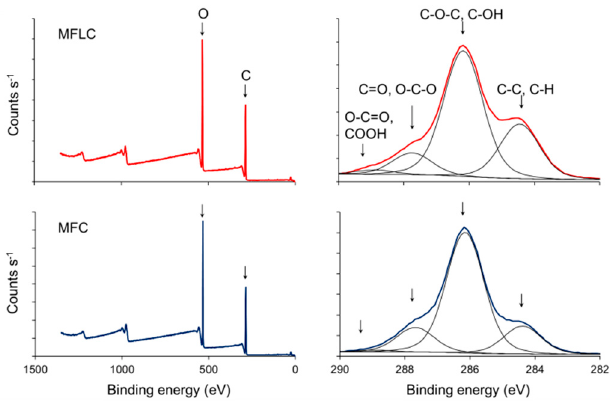
Figure 1. Detailed results of survey scans and high-resolution scans of the carbon peak from X-ray photoelectron spectroscopy (XPS) of MFLC and MFC.